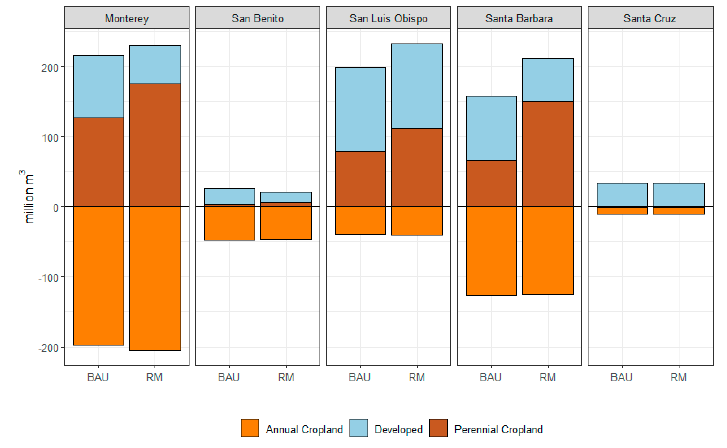
Figure 6. Net change in water demand in millions of cubic meters (Mm 3 ) from 2001–2100 by land use and land cover class and county for the business-as-usual (BAU) and recent modern (RM) scenarios.